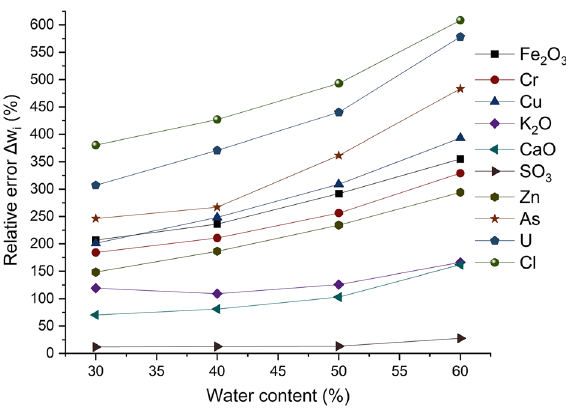
Figure 6. The relative error of XRF measurements as a function of water content, for all compounds contained in the phosphate